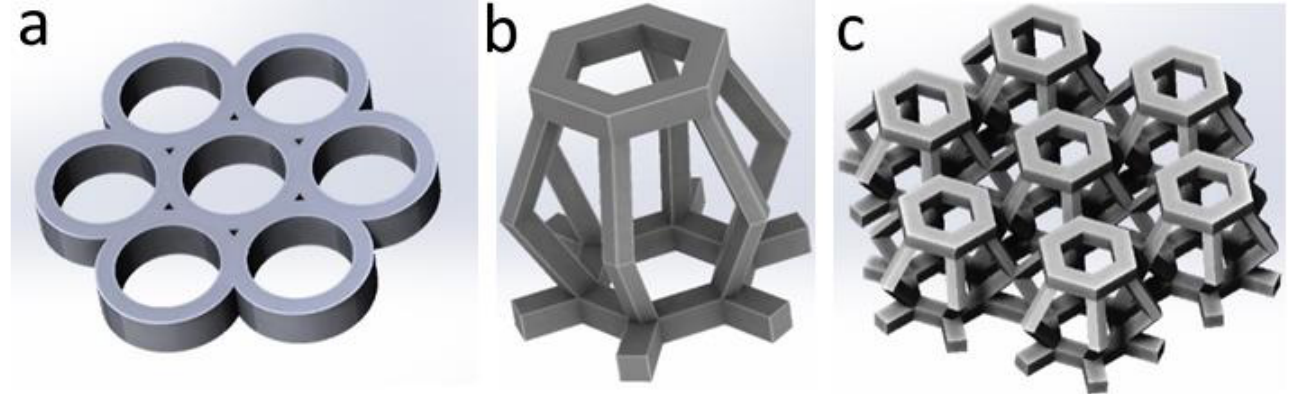
Figure 2. ( a ) 3D model for the structuring tests; ( b ) a structural element of ( c ) a hexagonal beam structure.